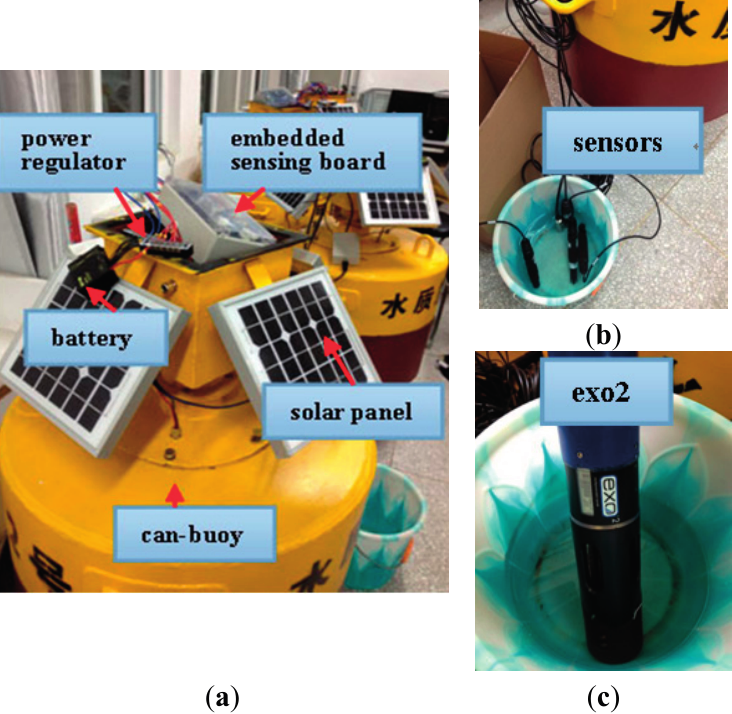
Figure 3. Components of an aquatic sensor node. ( a ) The functional modules; ( b ) Aquatic sensors; ( c ) The sonde